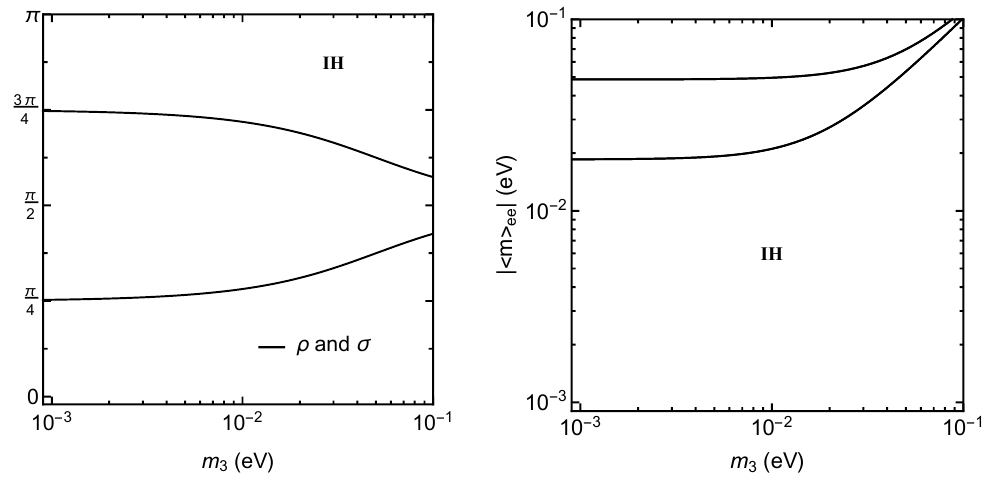
j as functions of the lightest neutrino mass m ee